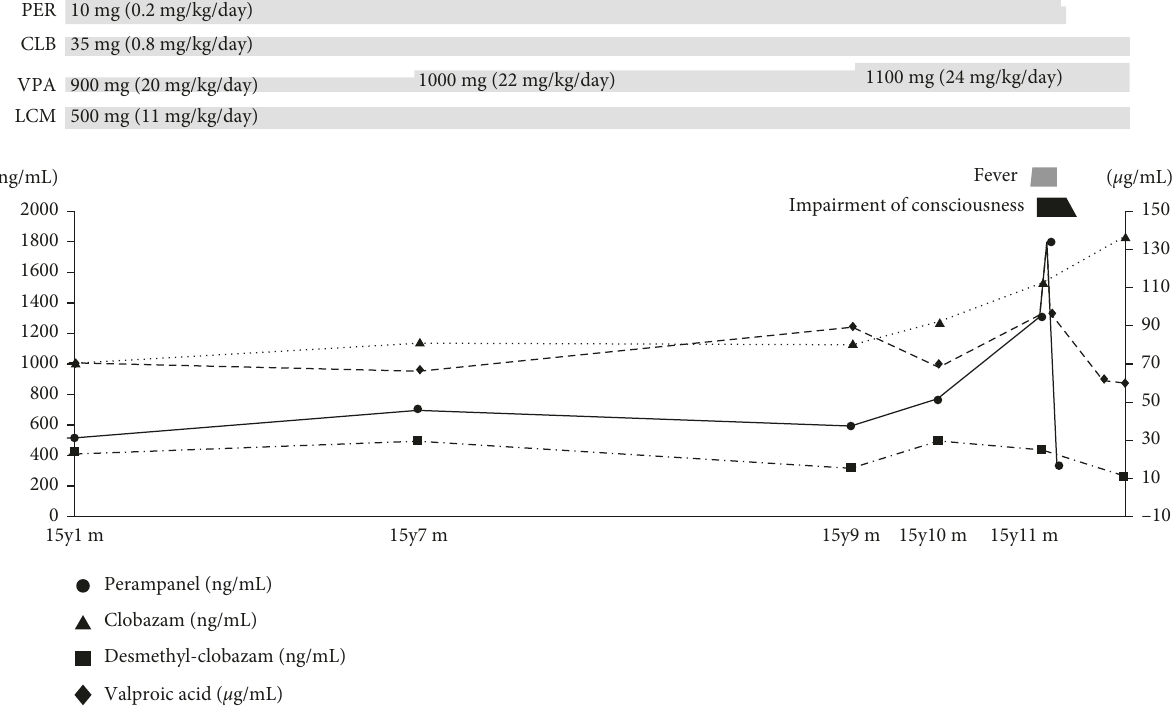
Figure 2: Clinical course. The patient’s fever resolved immediately after hospitalization but with persistence of the state of impaired consciousness. Perampanel concentration was elevated at the time of admission (1,300ng/ml) and ultimately increasing to a maximum of 1,790ng/ml. Cessation of perampanel treatment improved the level of consciousness. Seizures increased with decreasing plasma con- centration of perampanel. Fosphenytoin was initially introduced for seizure control, which was then switched to oral carbamazepine. The patient was discharged without apparent sequelae. VPA, valproic acid; CLB, clobazam; LCM, lacosamide; PER, perampanel; CBZ, carbamazepine. Table 1: Case reports of impaired consciousness due to